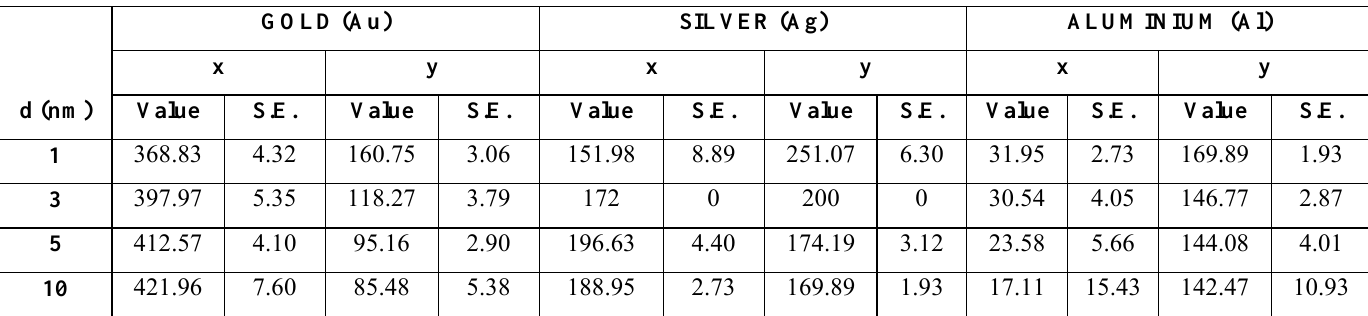
Table 1: Interparticle spacing dependent fitting parameters x and y of Au, Ag and Al homo-dimer nanostructure. GOLD